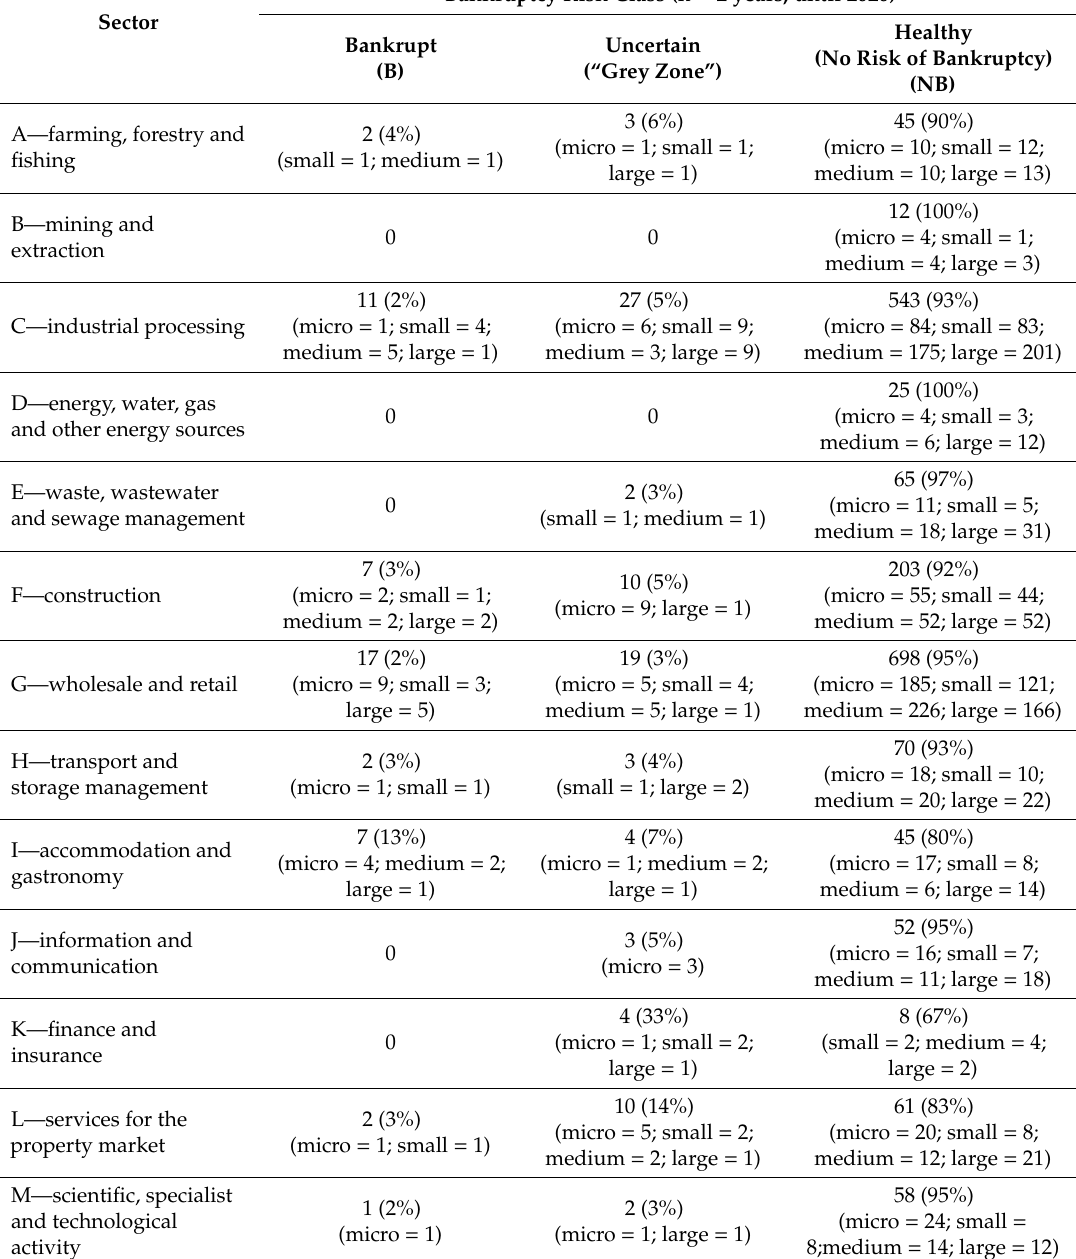
Table 4. Predicted number of businesses at risk of bankruptcy in time horizon h = 2 (until 2020) and predicted number of businesses in an uncertain condition in the Podkarpackie Voivodeship for various sectors. Number of Businesses Forecast by the Ensemble Scoring Model in a Sector